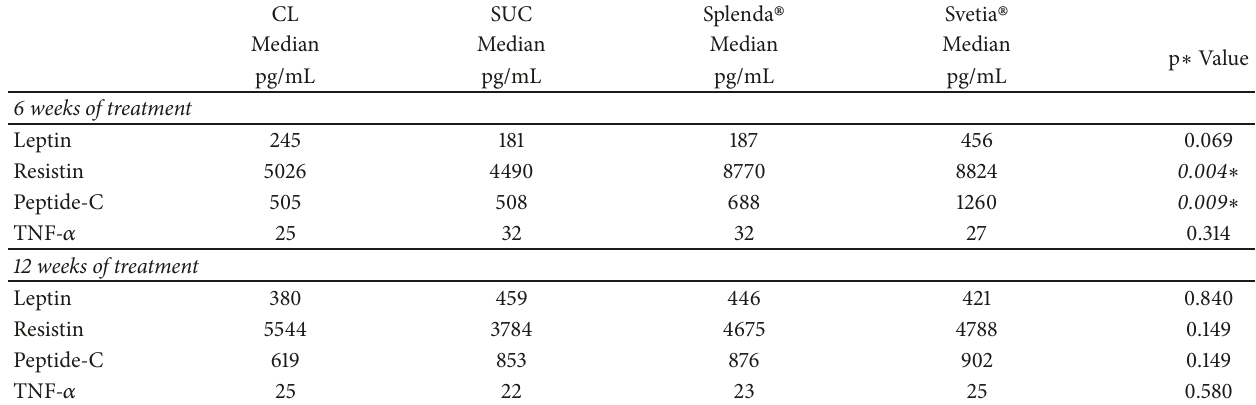
Table 3: Hormone profile of CD1 mice supplemented with sweeteners for 6 and 12 weeks.